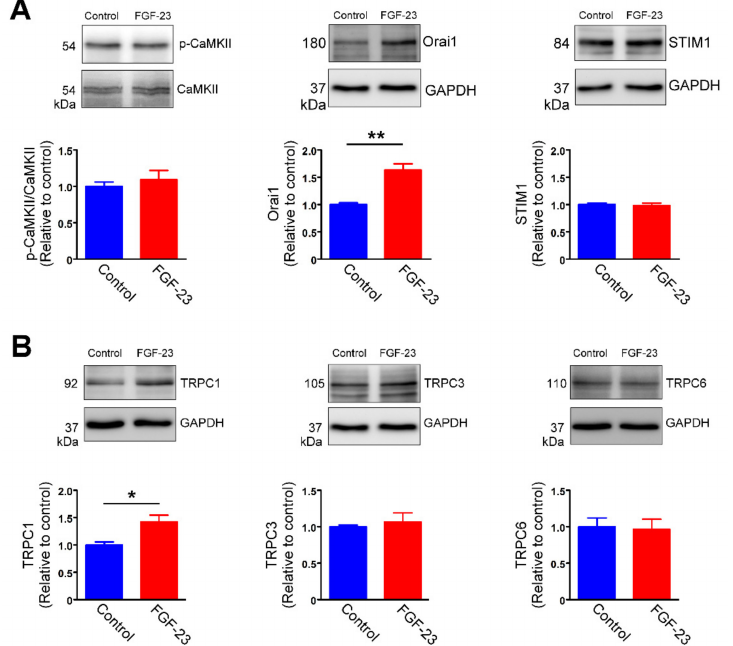
Figure 7. Fibroblast growth factor (FGF)-23 increases store-operated calcium channel